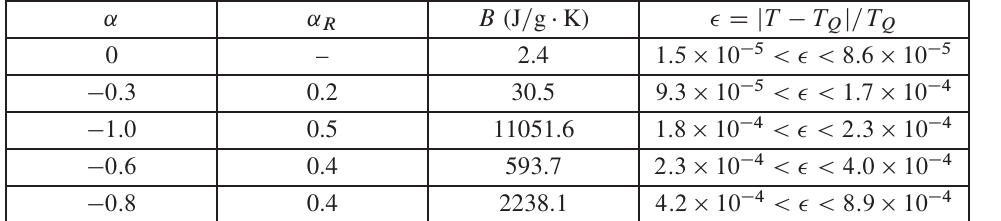
Table 5. Values of the critical exponent ˛ for the specific heat C p and the amplitude B within the temperature interval (cid:4) for the ˛ - ˇ phase transition ( T Q D 577:1 ı C) in quartz according to Eq. (1) where A D 1:2 J = g (cid:3) K. The experimental C p data [2] was analyzed above T Q along cooling curve. The renormalized ˛ R values (Eq. 3) are also given here.